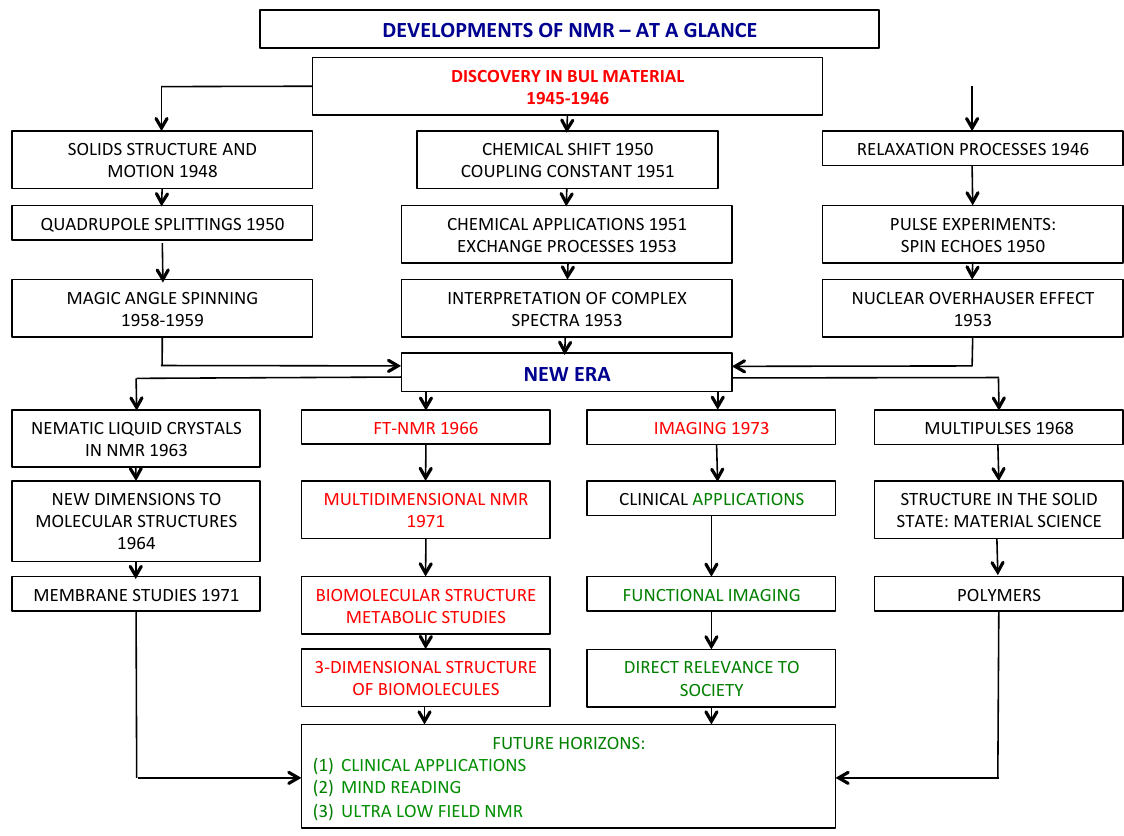
Figure 1. Developments of NMR at a glance.